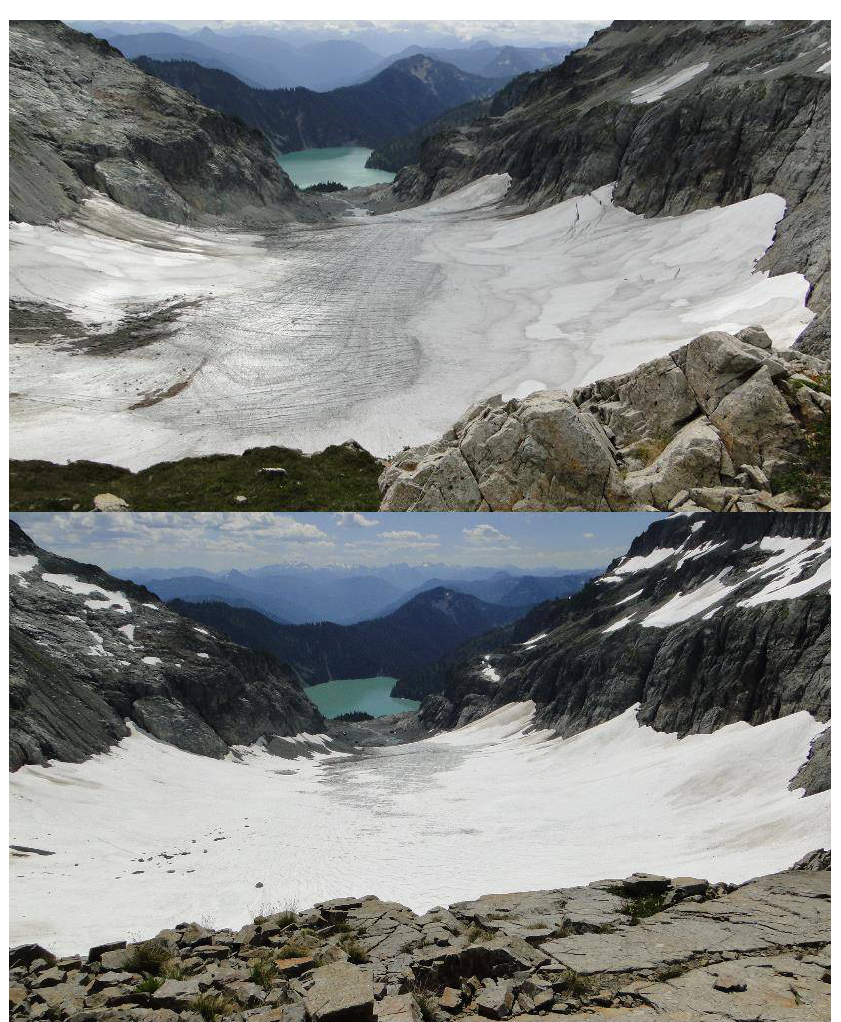
Figure 5. The Columbia Glacier from above the accumulation zone on 1 August 2015, with seven weeks left in the ablation season, little 2015 accumulation is retained. The Columbia Glacier from above the accumulation zone on 11 August 2016, with six weeks left in the accumulation season.